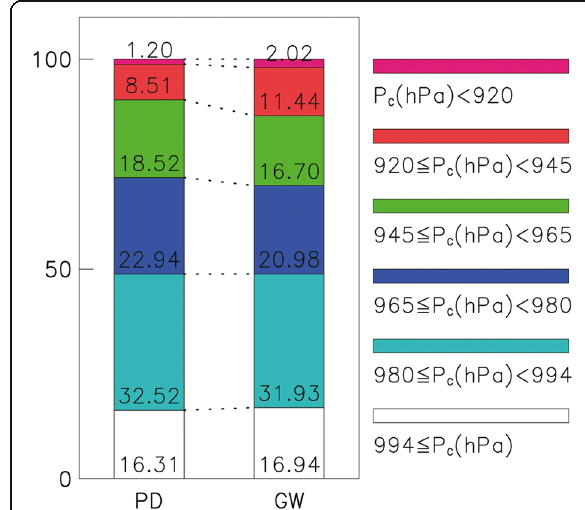
Fig. 14 Normalized frequencies (%) for each TC intensity from the PD and GW simulations. The two boxes represent the number of TCs categorized into six intensities using the lifetime minimum central sea-level pressure (Pc). The number in each colored box indicates the number of TCs categorized in each intensity